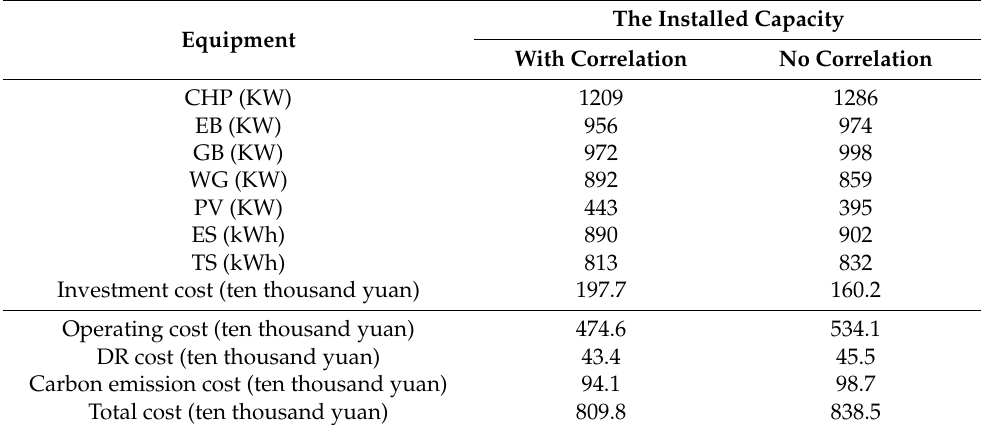
Table 4. Optimization results with and without